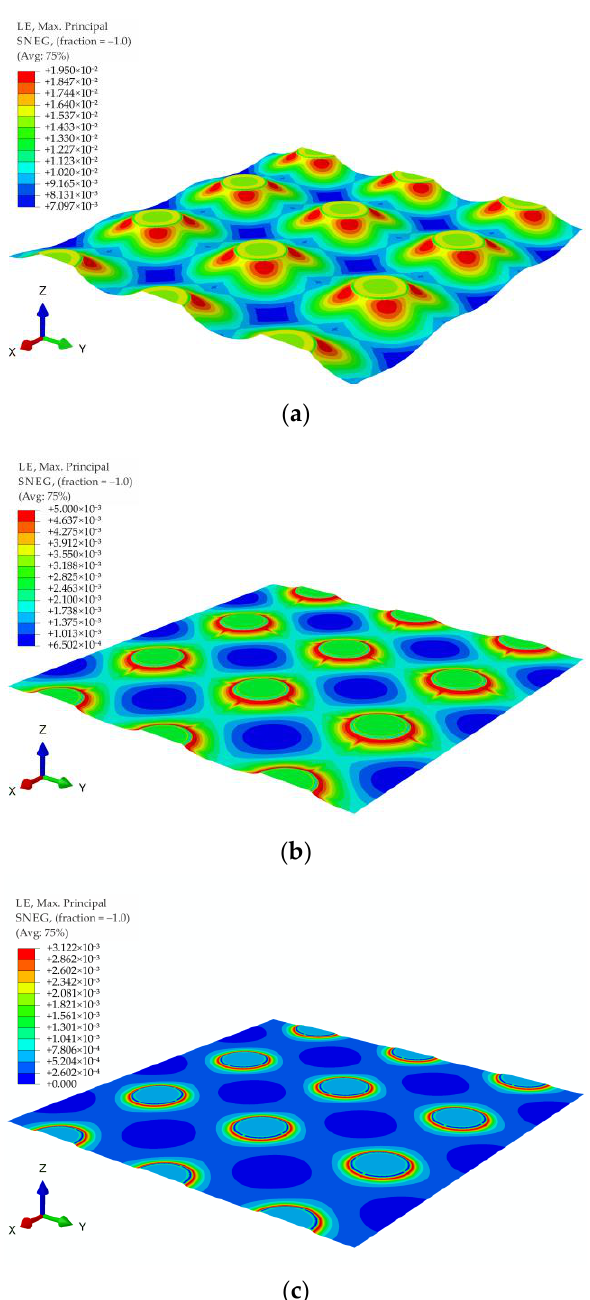
Figure 23. Deformation and maximum principal strain in reinforcement, variant B2: ( a ) k = 10 kN/m 3 ; ( b ) k = 150 kN/m 3 ; ( c ) k = 500 kN/m 3 .